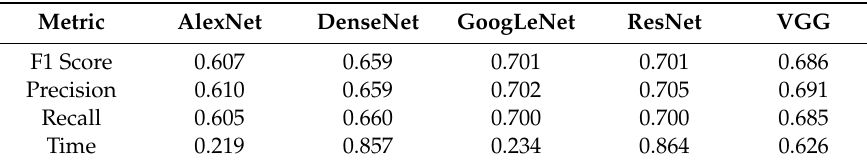
Table 3. Training with di ff erent algorithms.